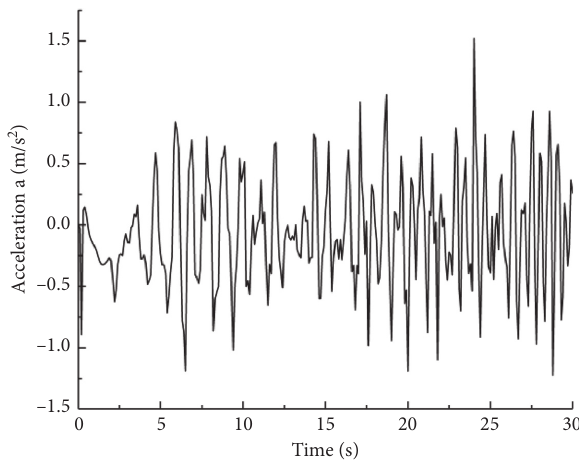
Figure 14: Variation curve of stochastic